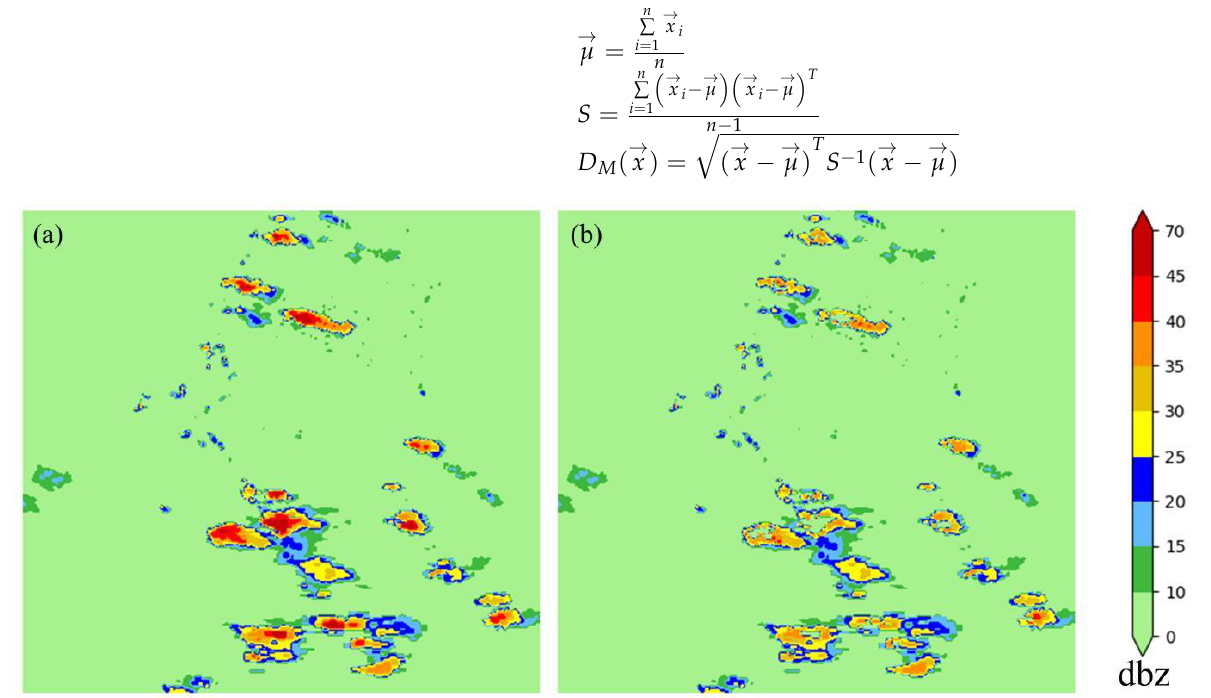
Figure 2. Sample comparison before and after denoising. ( a ) Original radar echo image. There is some noise caused by various factors in the original image. ( b ) Denoised image. The denoised image does not contain outliers and can be used directly by the model.